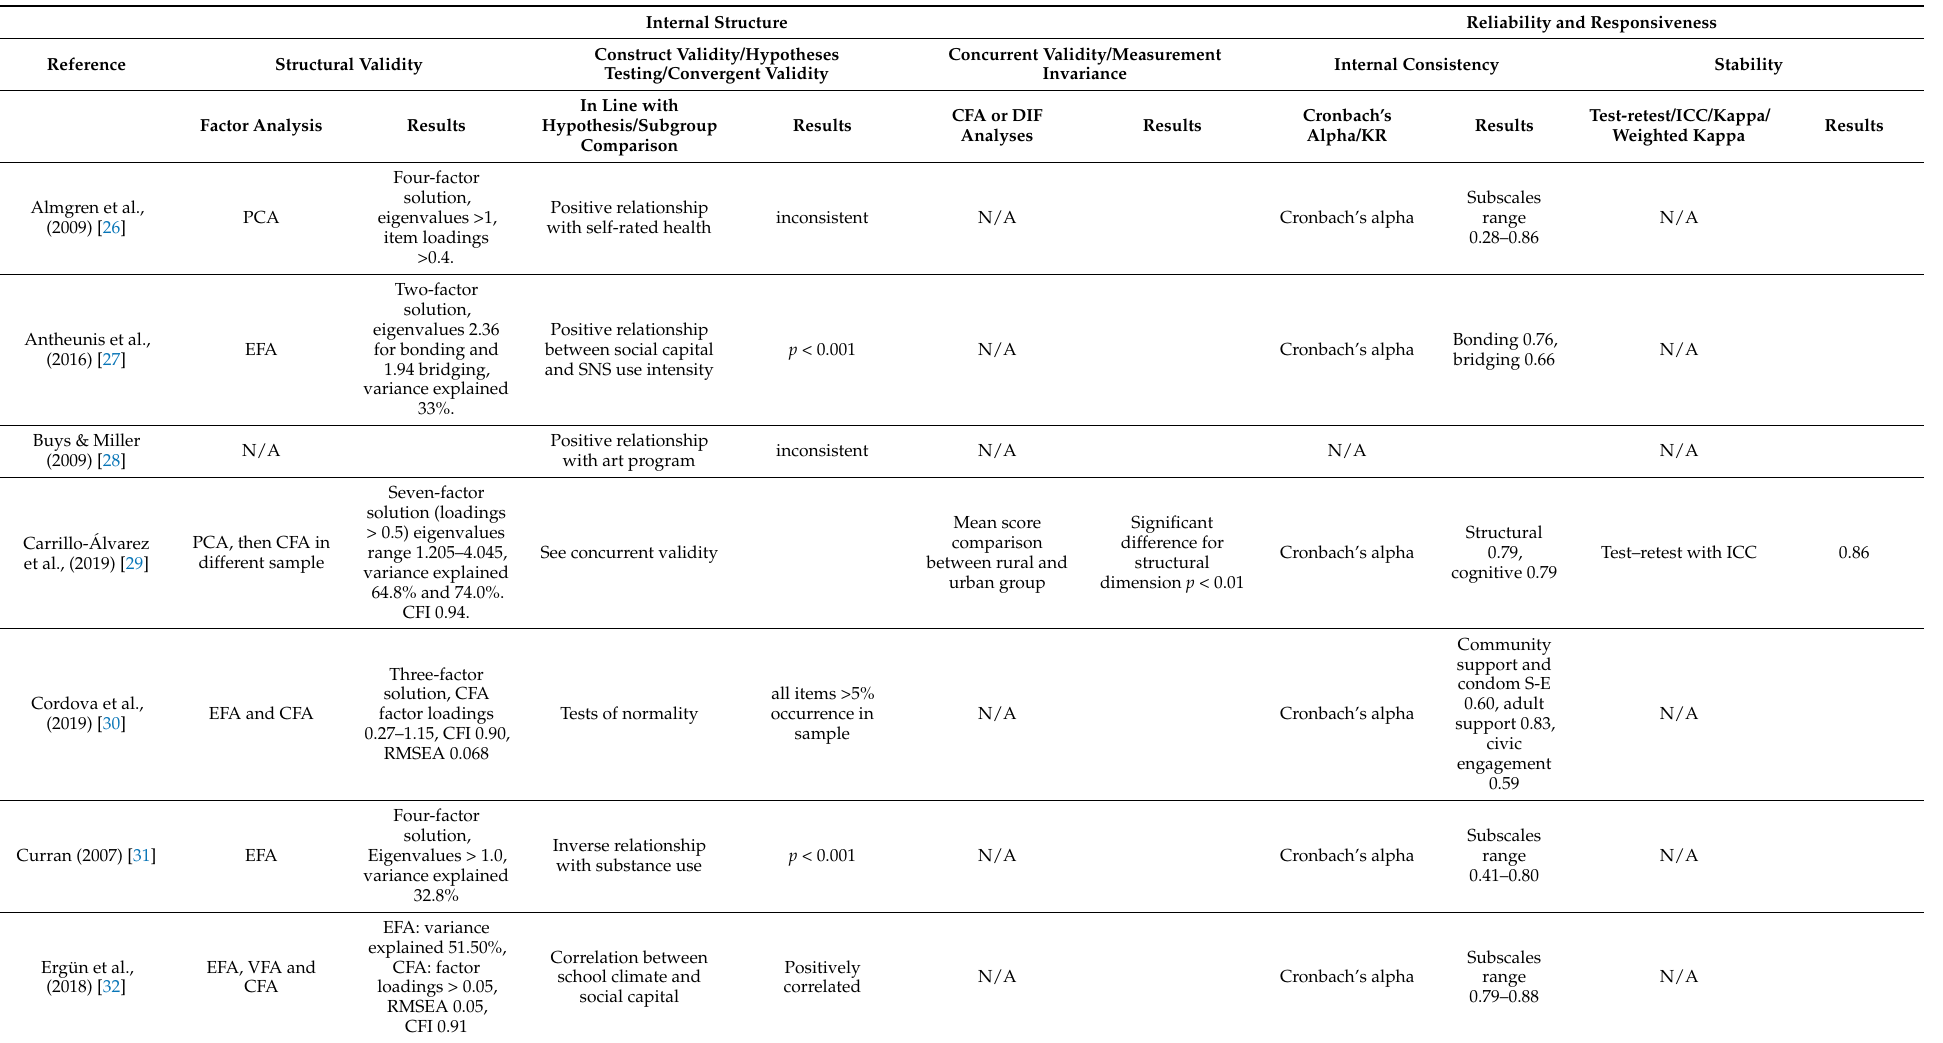
Table 5. Internal structure, reliability and responsiveness of instruments (COSMIN steps